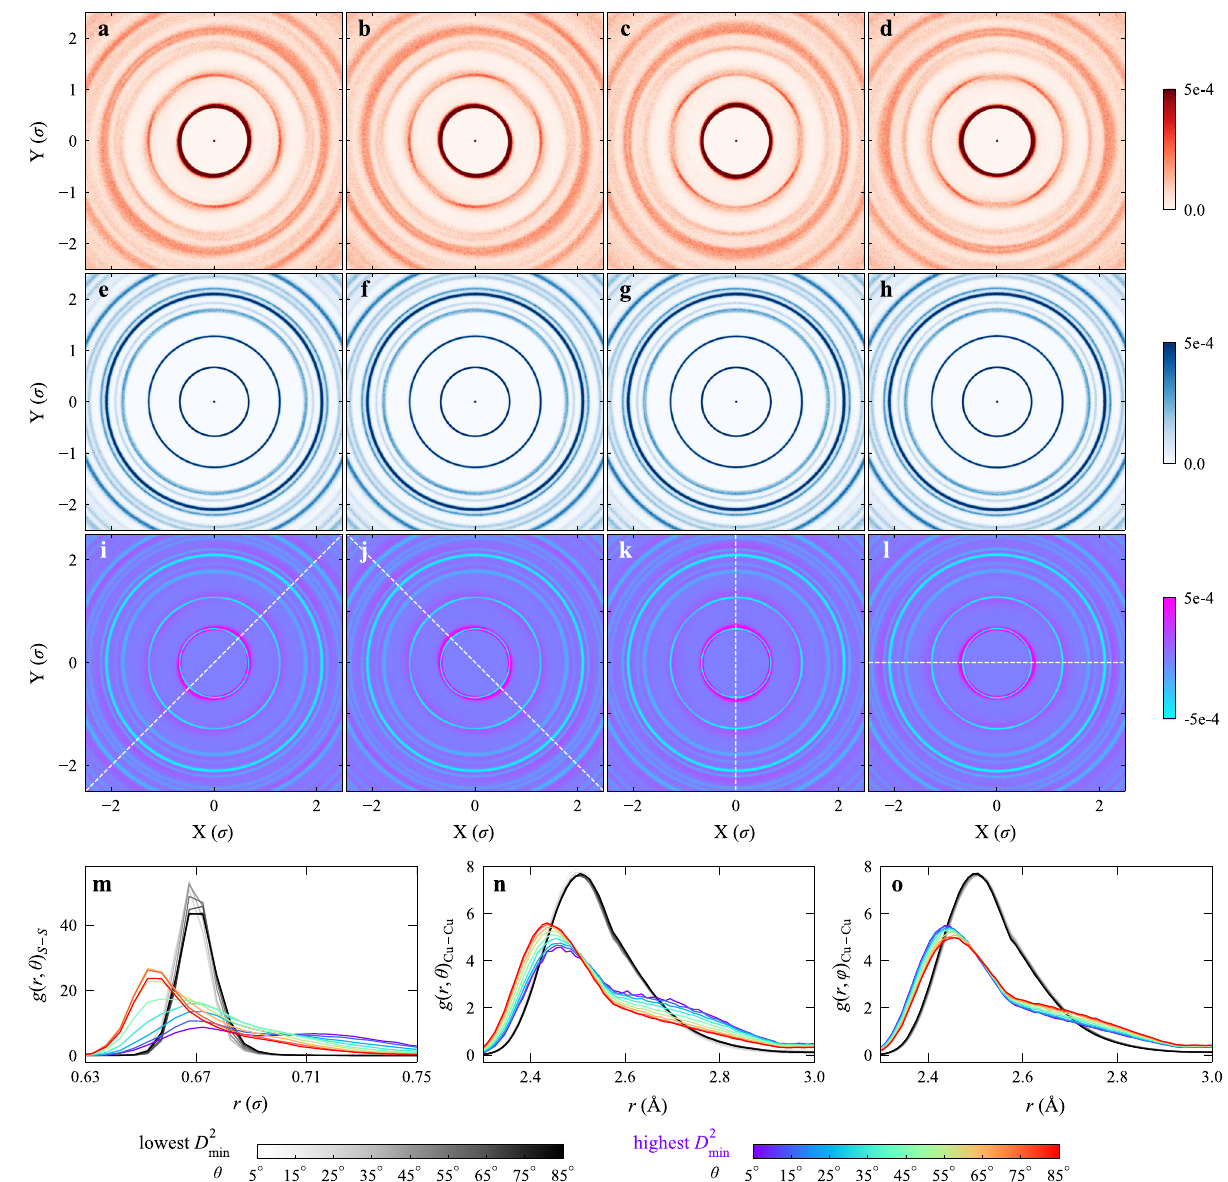
Fig. 2 Structural insight into the anisotropic local mechanical response. Each map in a – h shows the average SDM of the S particles in the neighborhood up to medium range for all S particles that have been identi fi ed to have large or small D 2 min when sheared to 3.0% strain, in 5000 2D samples, for one of the four different loading protocols (from left to right: positive simple shear, negative simple shear, positive pure shear, and negative pure shear). The SDM was calculated for these particles in the initial undeformed con fi gurations. a – d for central particles with top 0.5% of D 2 min , while e – h for those with the lowest 0.5% of D 2 min . i – l The difference in SDMs, which is calculated using the fi rst row ( a – d ) minus the second row ( e – h ). The white dashed line in ( i – l ) represents the macroscopic elongation direction, ζ . m Orientational partial ( S -centered) pair correlation function g ζ r ; θ ð Þ for S – S correlation. Each g ζ r ; θ ð Þ curve is an average, over all samples and all loading orientations. For the 3D Cu 50 Zr 50 glass, we show two orientational pair correlation functions for atoms that showed extreme D 2 min upon straining to 5%. n , o Cu-centric g ζ r ; θ ð Þ and g ζ r ; φ